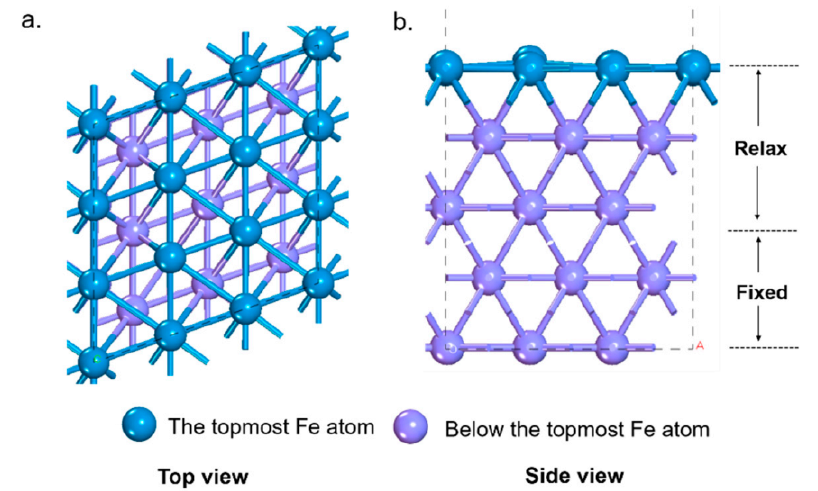
Figure 7. The computed slab model of Fe (110): ( a ) top view; ( b ) side